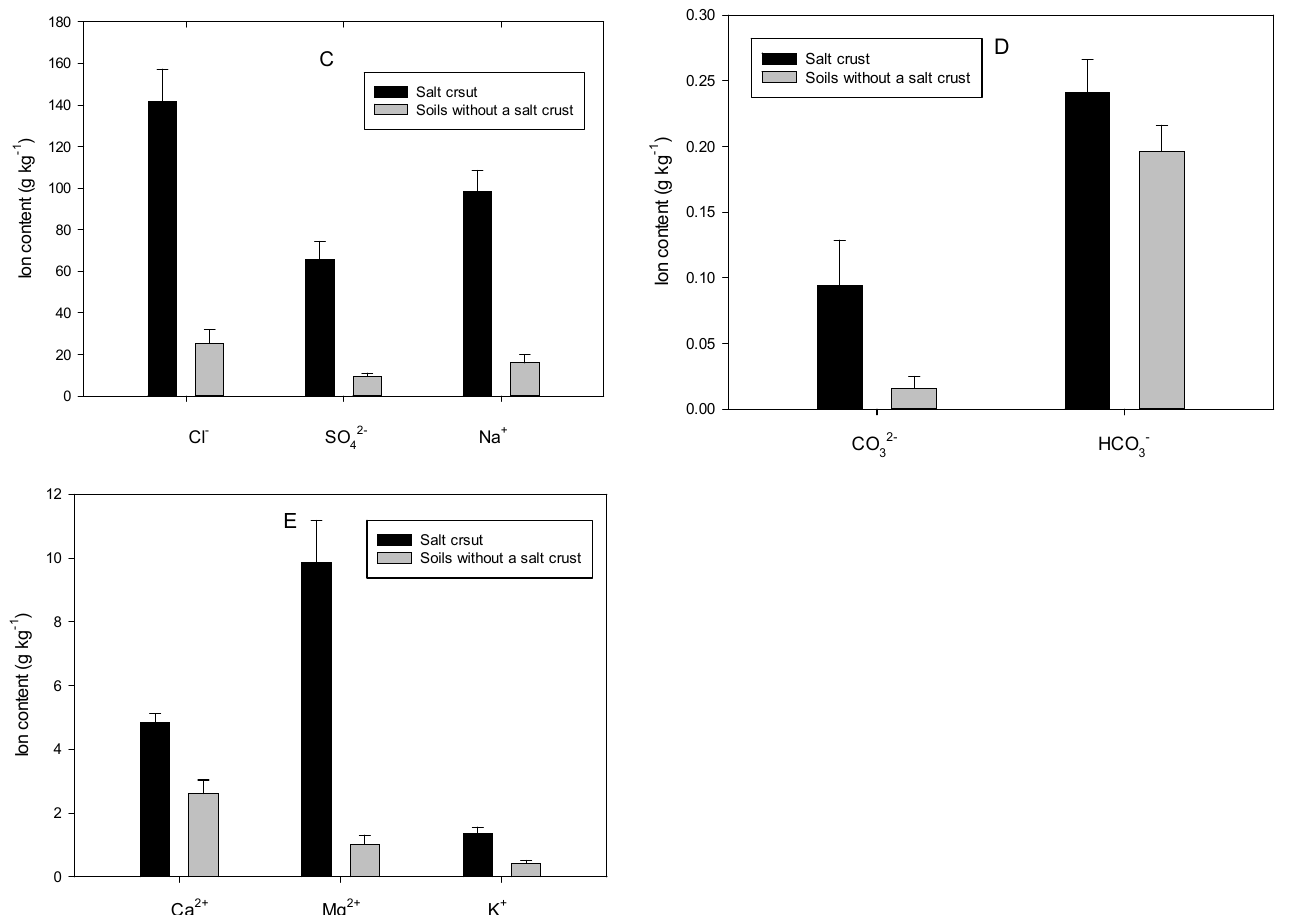
Figure 2. Total salt content, EC, and ion content in soils with and without a salt crust. ( A ) the salt content; ( B ) EC; ( C ) Cl − , SO 42 − and Na + ; ( D ) CO 32 − and HCO 3 − ; ( E ) Ca 2+ , Mg 2+ and K + . A higher content of SO 42 − was also observed in the salt-crusted soils than in the non- crusted soils, with a mean of 65.55 g·kg − 1 (8.88 g·kg − 1 SE), whereas in soils without a salt crust, the mean value was 9.57 g·kg − 1 (1.49 g·kg − 1 SE). The salt crust contents of Mg 2+ and Ca 2+ were 9.87 g·kg − 1 (1.31 g·kg − 1 SE) and 4.85 g·kg − 1 (0.26 g·kg − 1 SE), respectively. The con- (0.27 g·kg − 1 SE) and 2.62 g·kg − 1 (0.42 g·kg − 1 SE), respectively. K + , HCO 3 − , and CO 32 − all had